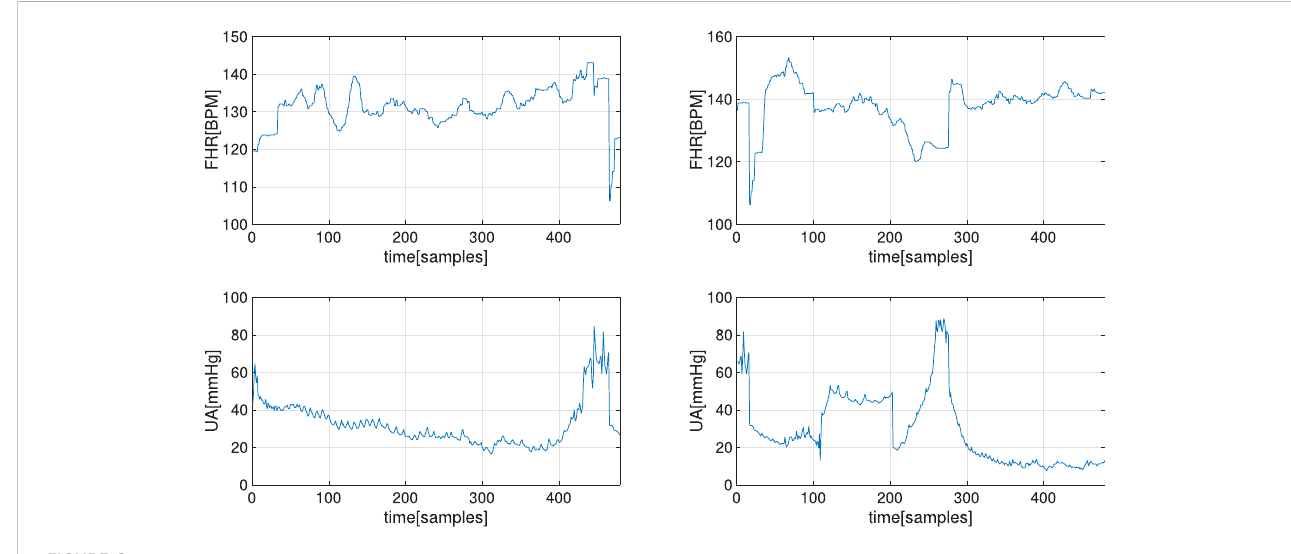
FIGURE 6 The two CTG segments, i.e., FHR (top) and UA (bottom) recordings, used for estimating of random missing samples in